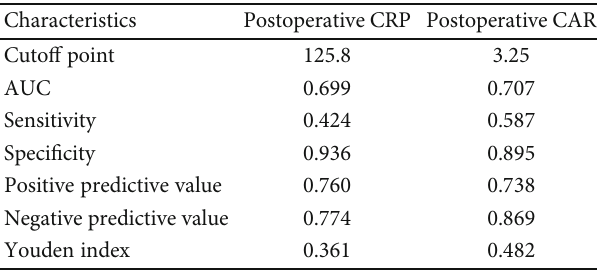
Figure 1: ROC curve showing postoperative CAR and CRP on POD3 levels predict postoperative complications. CAR: the C- reactive protein/albumin ratio; CRP: C-reactive